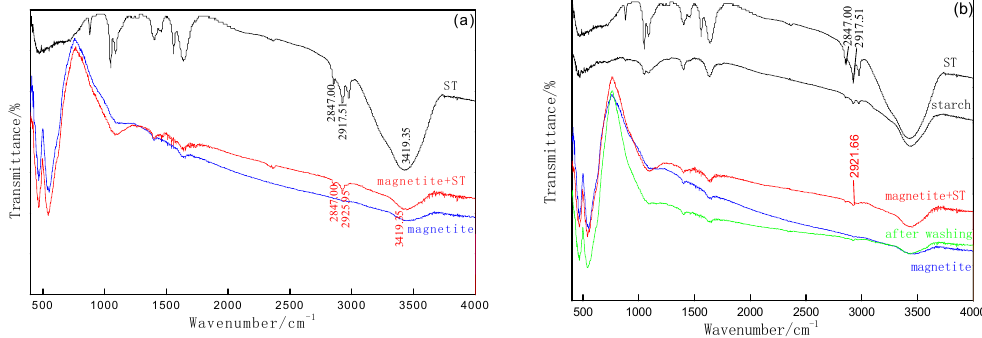
Figure 14. Infrared spectra of magnetite before and after the action of ( a ) toluenesulfonamide(ST). and ( b ) starch and toluenesulfonamide(ST).